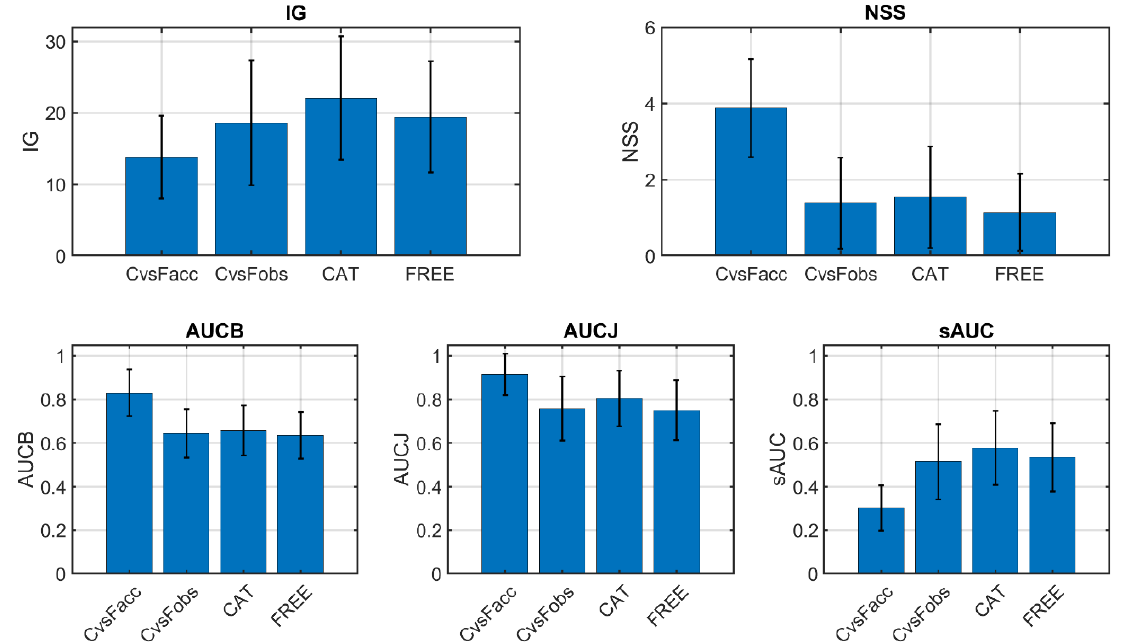
Figure 6. Inter-experiment and inter-observer heat map comparison metrics. CAT: category counting experiment. FREE: free-viewing experiment. CvsFAcc: inter-experiment comparison with accumulated heat maps. CvsFobs: inter-experiment comparison with individual observer data.